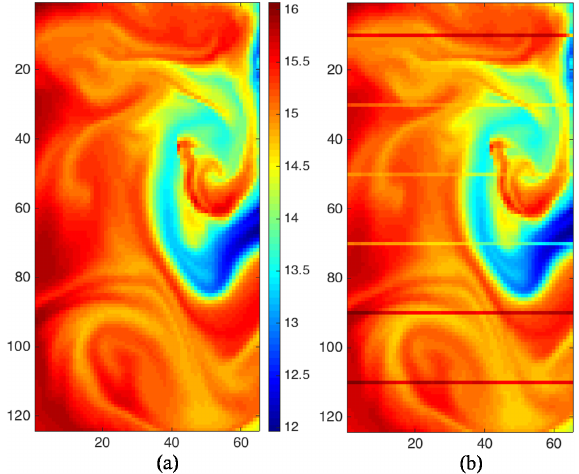
Figure 1. Panel (a) shows (simulated) variations of sea surface tem- perature off the coast of Oregon, USA, on 1 August 2002. The im- age was generated from a Regional Ocean Model System (ROMS, Courtesy of John Osborne, Oregon State University), using the data assimilation from the Geostationary Operational Environmen- tal Satellite (GOES). Panel (b) is created by adding artificial stripes to every 20th